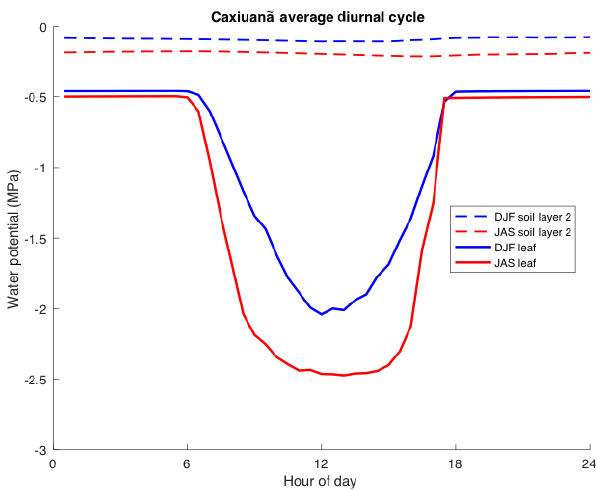
Figure 11. Climatology of the diurnal cycle of leaf water potential and topsoil water potential in the dry and wet seasons in Caxiuanã, Brazil, simulated by the Community Land Model (CLM) with plant